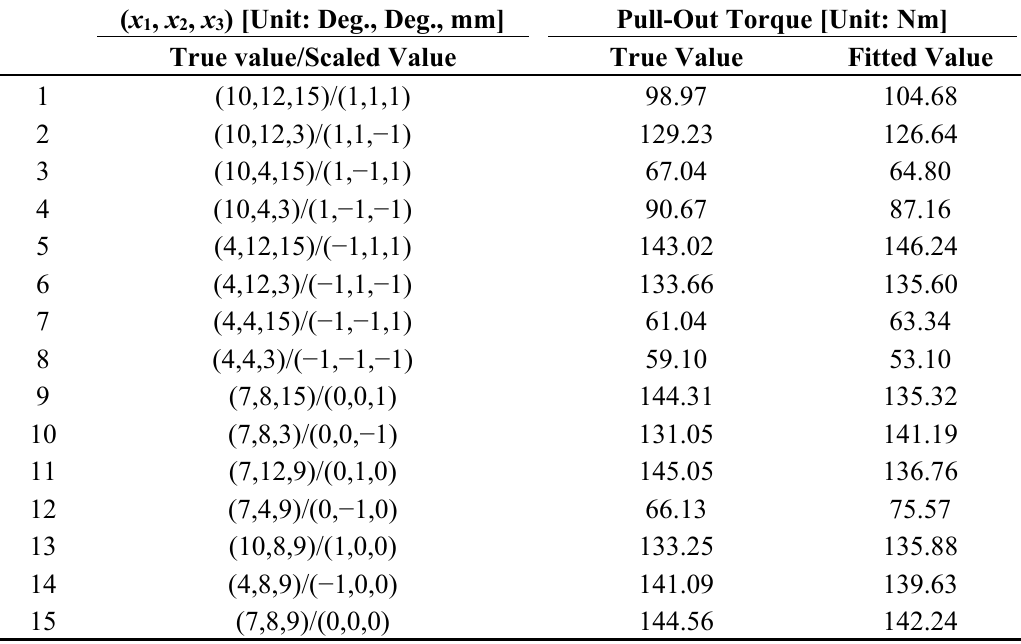
Table 2. Experiment results using central composite design (CCD) for optimizing rotor slot.